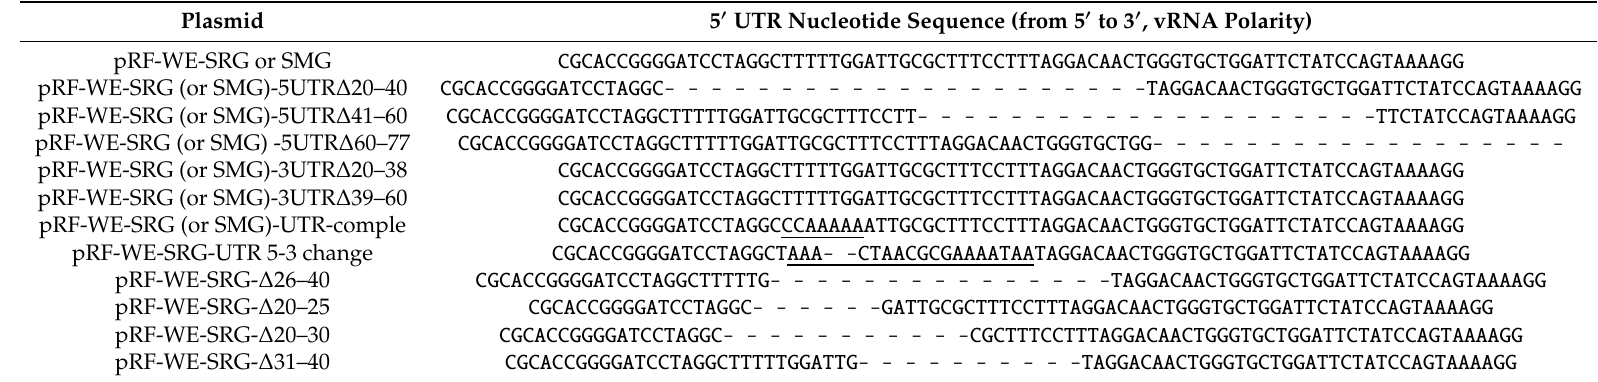
Table 1. The 5 (cid:48) nucleotide sequences of untranslated regions (UTRs) of plasmids for the reverse genetics and minigenome systems. Plasmid 5 (cid:48) UTR Nucleotide Sequence (from 5 (cid:48) to 3 (cid:48) , vRNA Polarity)